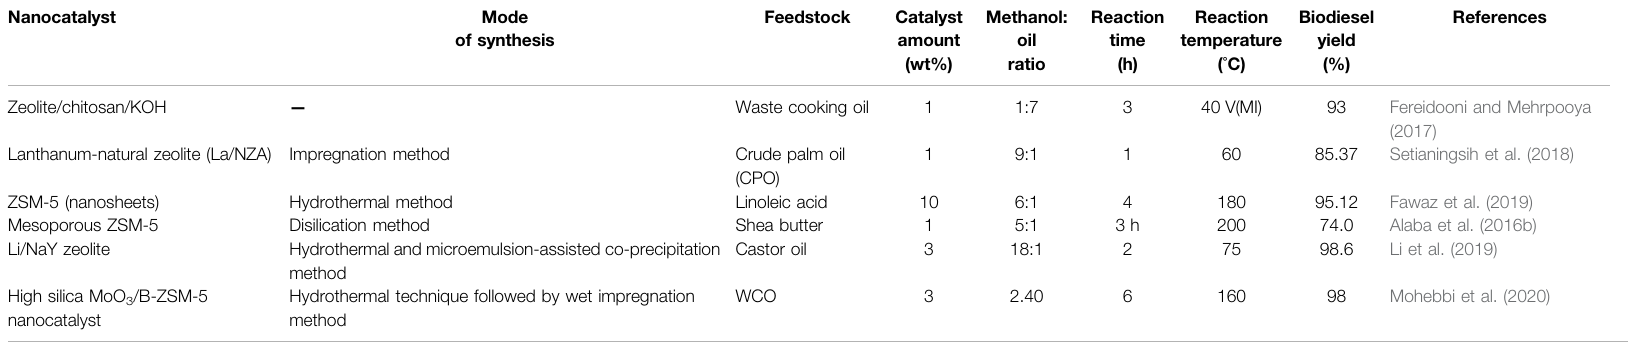
TABLE 6 | The summary of zeolite-based nanocatalysts for increased biodiesel production.